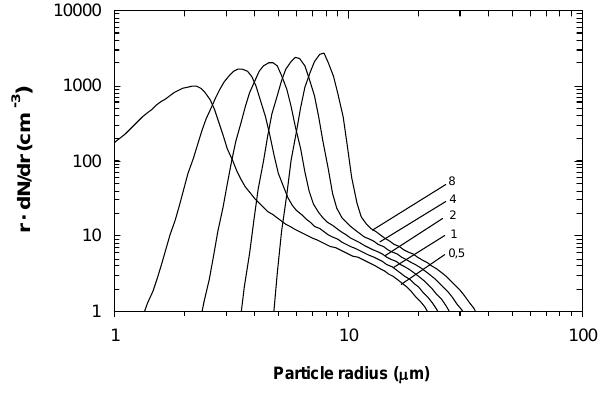
Figure 8. Evolution of simulated cloud drop spectrum at the introduction of salt powder with 3 Fig. 8. Evolution of simulated cloud drop spectrum at the intro- the mass concentration of 1 mg/m 3 (the numbers at the curves – time (min.) after the 4 duction of salt powder with the mass concentration of 1mg/m 3 (the beginning of the cloud medium formation). 5 numbers at the curves – time (min.) after the beginning of the cloud medium